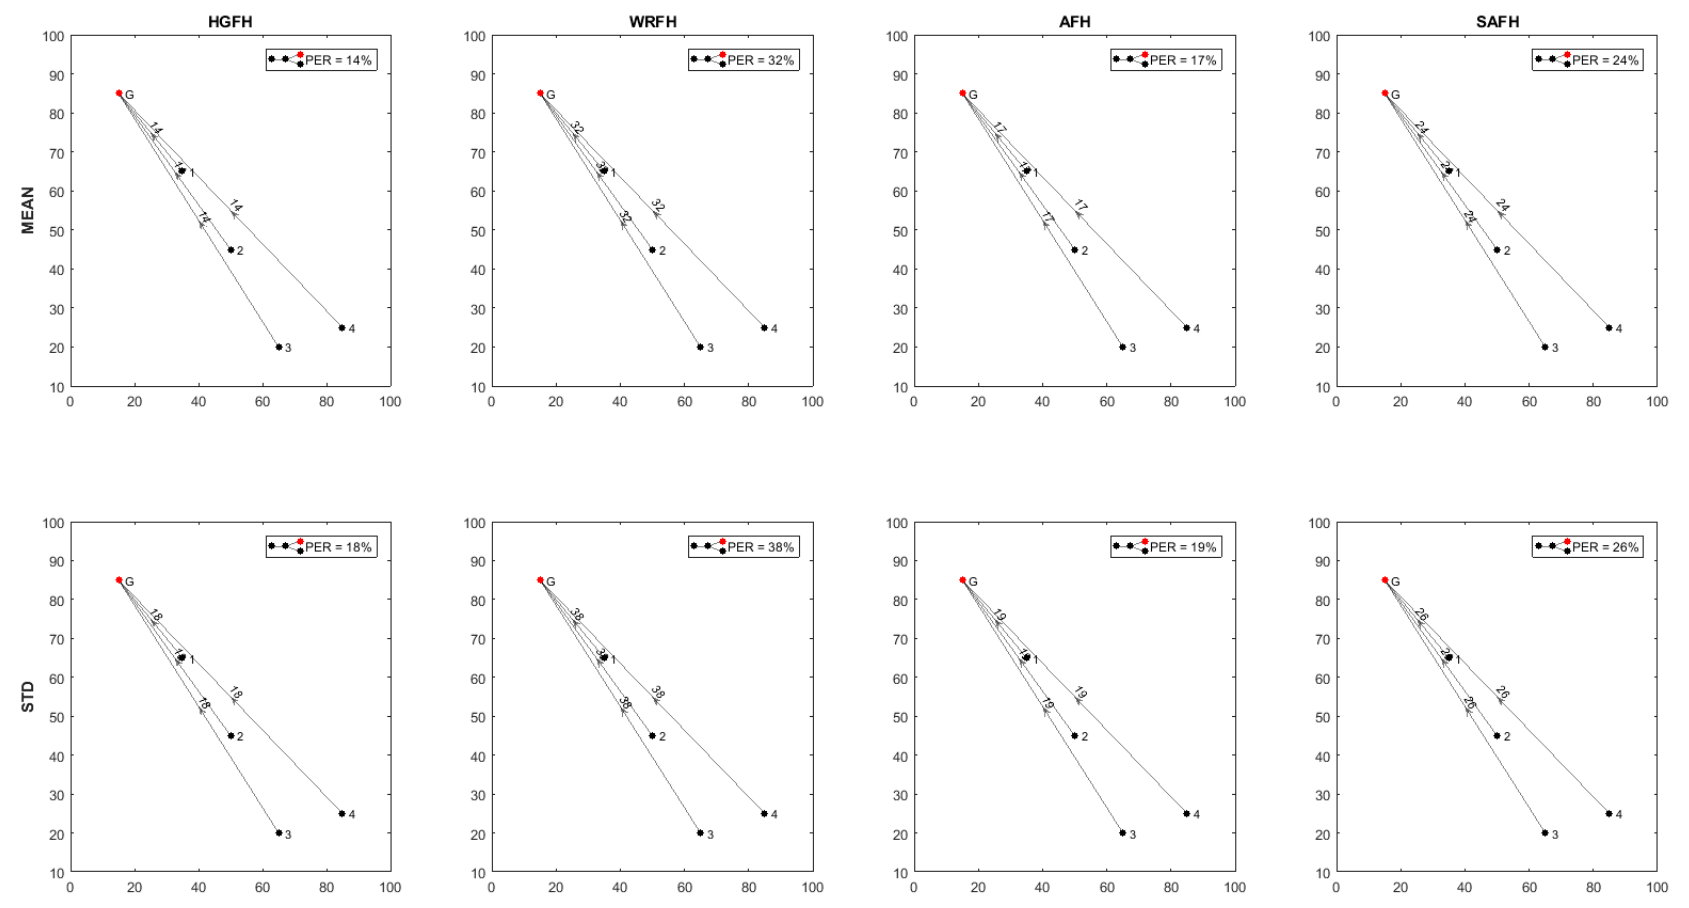
Figure 23. Inferred topologies with w PER = 1 and w DIST = 0. Minimizing the overall PER results in direct connections between nodes and gateway for all the hopping techniques and quality metrics.